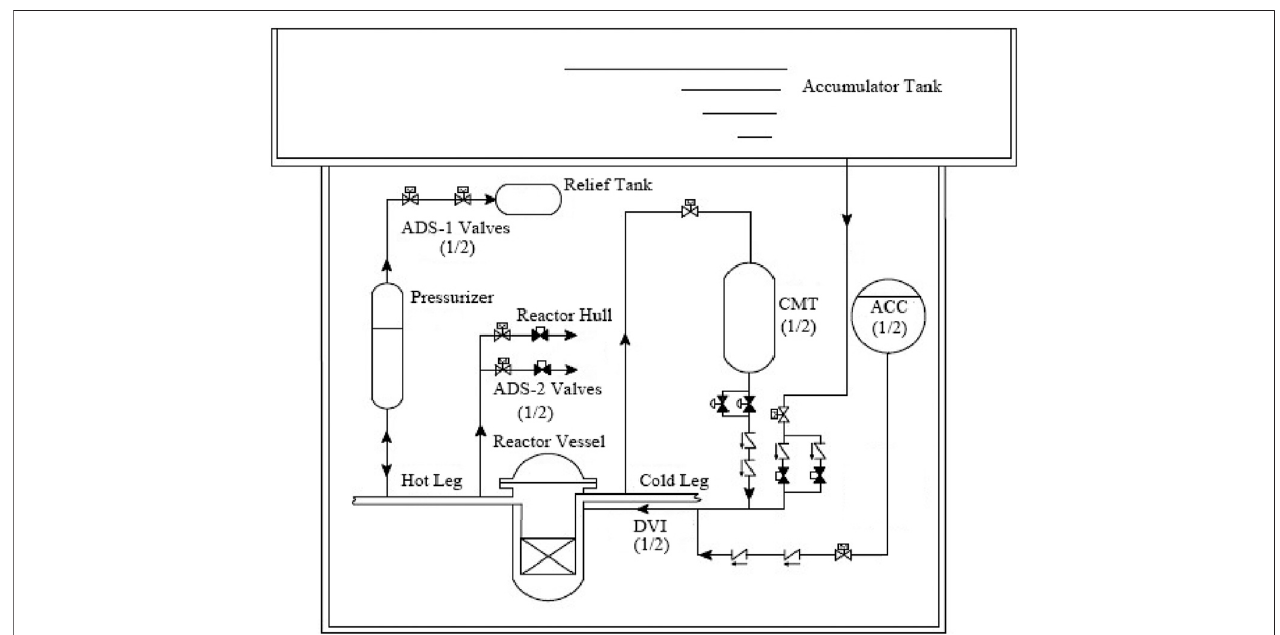
FIGURE 1 | Passive safety injection system con fi